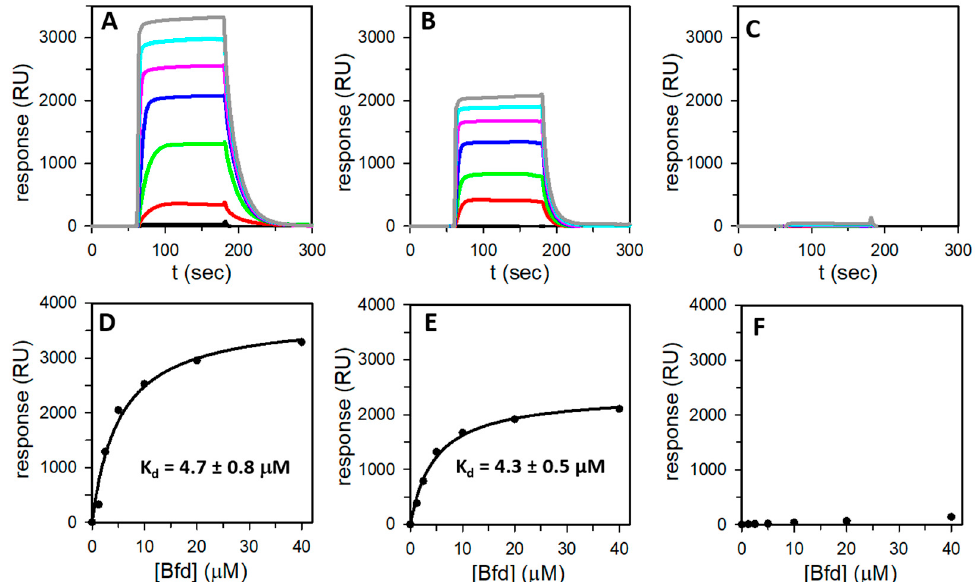
Figure 8. Bfd binds Bfr at the surface of BfrB inter-subunit dimers. The association between Bfr and Bfd was studied with the aid of SPR. Reference and baseline-subtracted responses obtained from flowing Bfd solution over: ( A ) immobilized Bfr containing only BfrB subunits, isolated from cells cultured in 21% O 2 (see Table 1), ( B ) immobilized Bfr containing 45% FtnA isolated from cells cultured in 2% O 2 , and ( C ) immobilized FtnA rec . The concentrations of Bfd are 0 µM (black), 1.25 µM (red), 2.5 µM (green), 5 µM (blue), 10 µM (pink), 20 µM (cyan), and 40 µM (grey). The binding affinity was determined by steady-state analysis. ( D , E ) The steady state responses shown in ( A , B ), respectively, plotted as a function of Bfd concentration (black circles) and fitted to the binding model (solid line) described by equation 2. ( C , F ) Bfd does not bind to FtnA rec . Table 2. The association between Bfd and Bfr as determined by SPR.